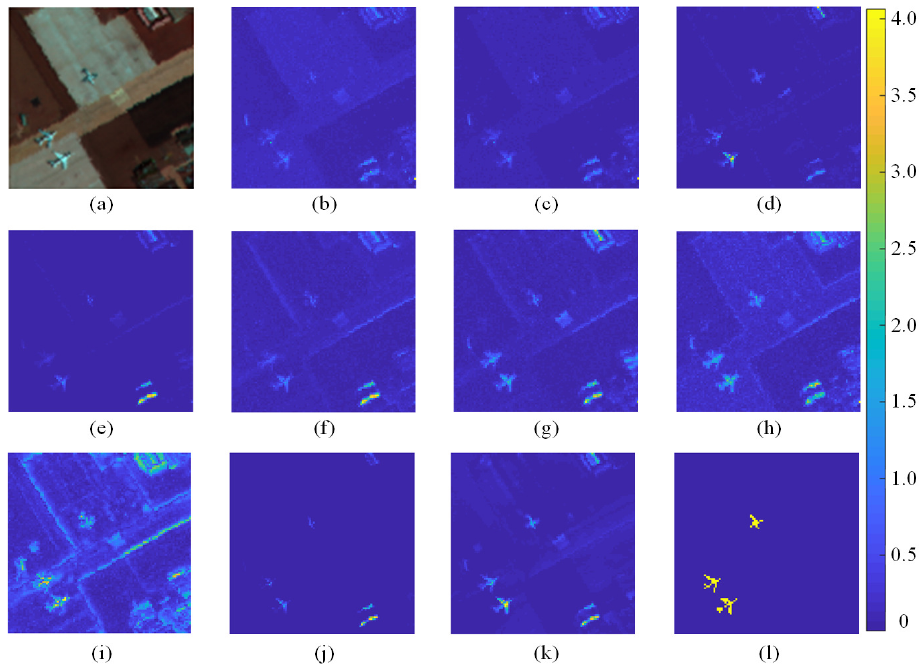
Figure 7. Detection results on the AVIRIS-II dataset: ( a ) Pseudo-color image; ( b ) RX; ( c ) RX-DWT; ( d ) RX-Kernel; ( e ) RPCA; ( f ) LSMAD; ( g ) LRASR; ( h ) FrFE; ( i ) GTVLRR; ( j ) FEBPAD; ( k ) ours; ( l ) ground